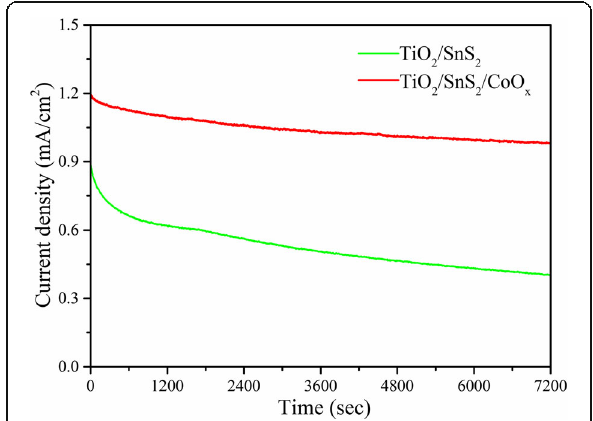
Fig. 5 Steady-state photocurrent density curves of the TiO 2 /SnS 2 and TiO